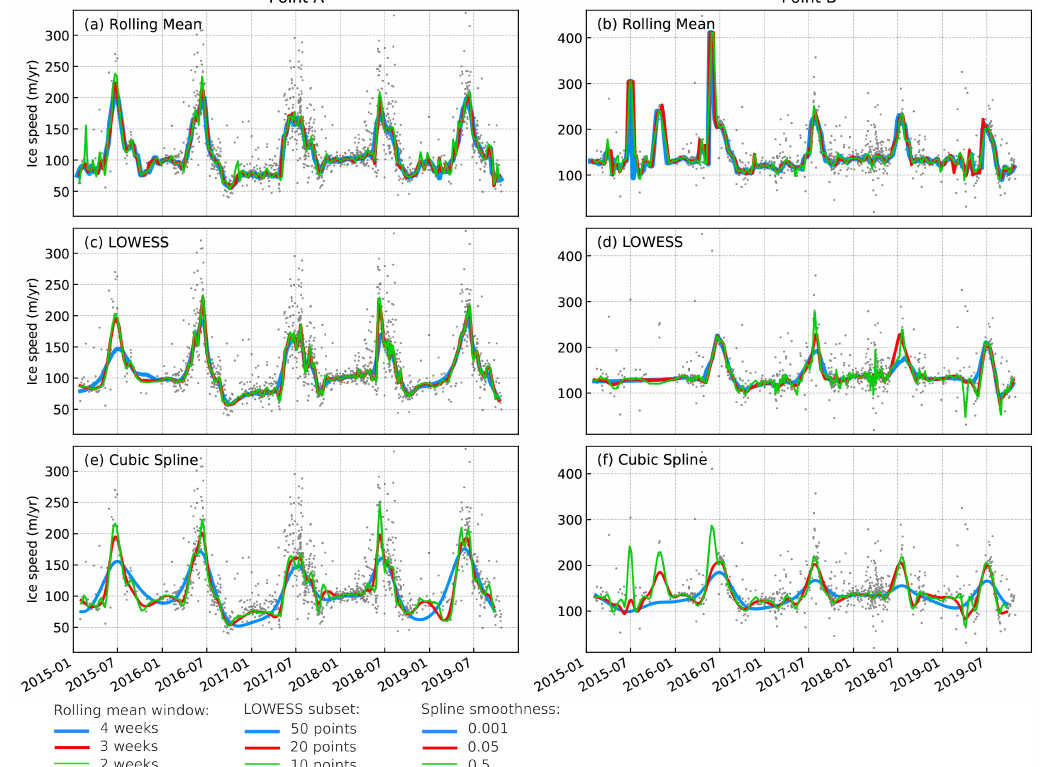
Figure 9. Statistical and regression approaches applied on our time series of ice velocity. ( a , b ) Rolling mean using subset window sizes of 1, 2, and 4 weeks on our time series. ( c , d ) Moving non-parametric regression (LOWESS) for different fraction parameters f corresponding to subsets of 10, 20, and 50 measurements applied on our time series. ( e , f ) Cubic spline regression using a smoothing parameter of f = 0.001,0.05,0.5. Left column correspond to the time series in point A and right column for point B as indicated by the red stars in Figure